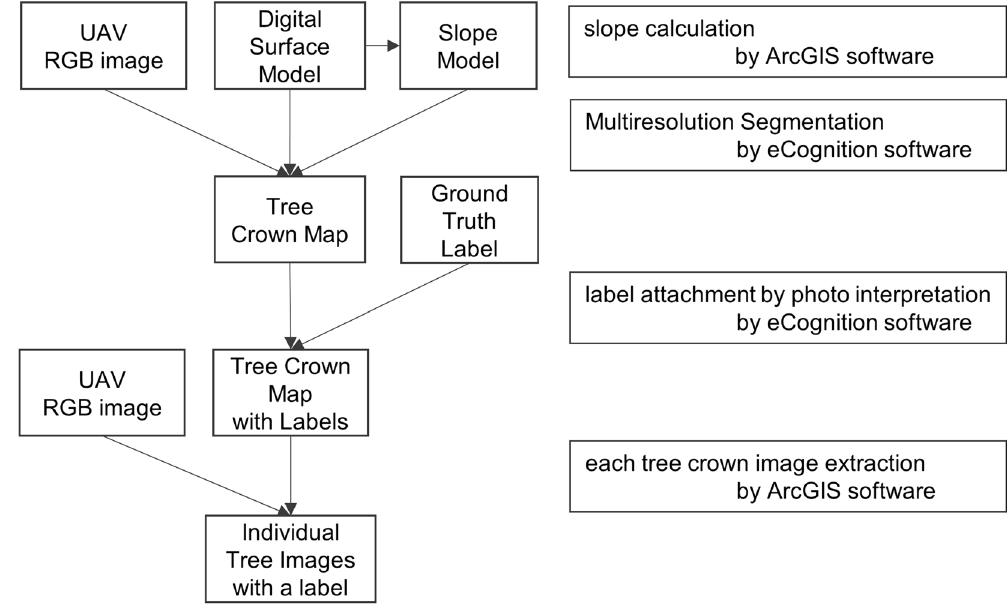
Figure 1. Workflow for supervised images